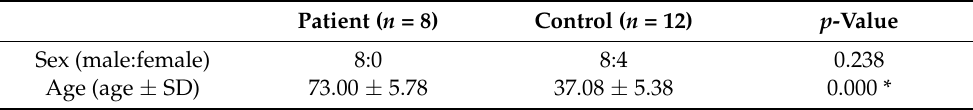
Table 2. Demographic information of each